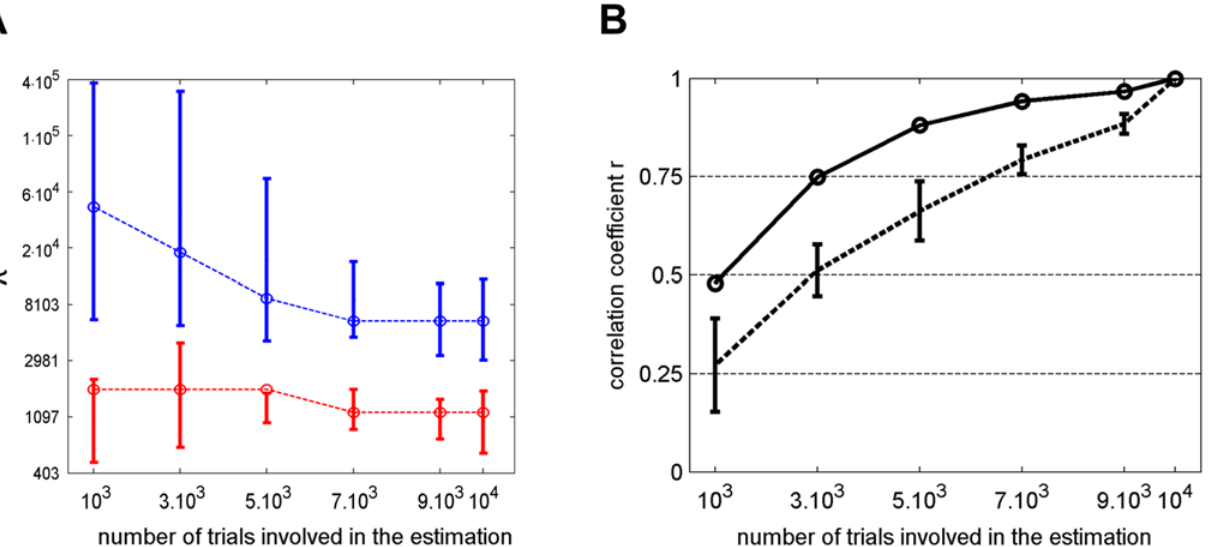
Fig 8. Effect of the number of trials involved in the estimation. A. Evolution of ~ l ~ for a different number of trials. Red circles indicate the result of the conjoint optimization, and red error bars indicate the standard deviation of the individual lambdas. Blue circles and blue error bars indicate the position of the minimum value of the CVD function for groups and individuals, respectively. B. Correlation between ACIs estimated on n trials, and final ACI ( λ = 1,191). Dotted line: mean and standard deviation of the correlation for individual ACIs; thick line: correlation for the mean ACI for the participants